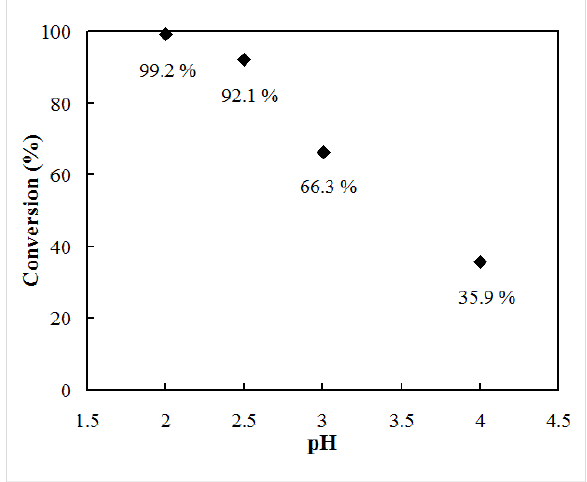
Figure 6: Effect of pH on the conversion of 0.01 M p -nitrophenol by using 0.05 M formic acid. The porous PdO coated reactor was used at 30 °C and a residence time of 14.7 s.